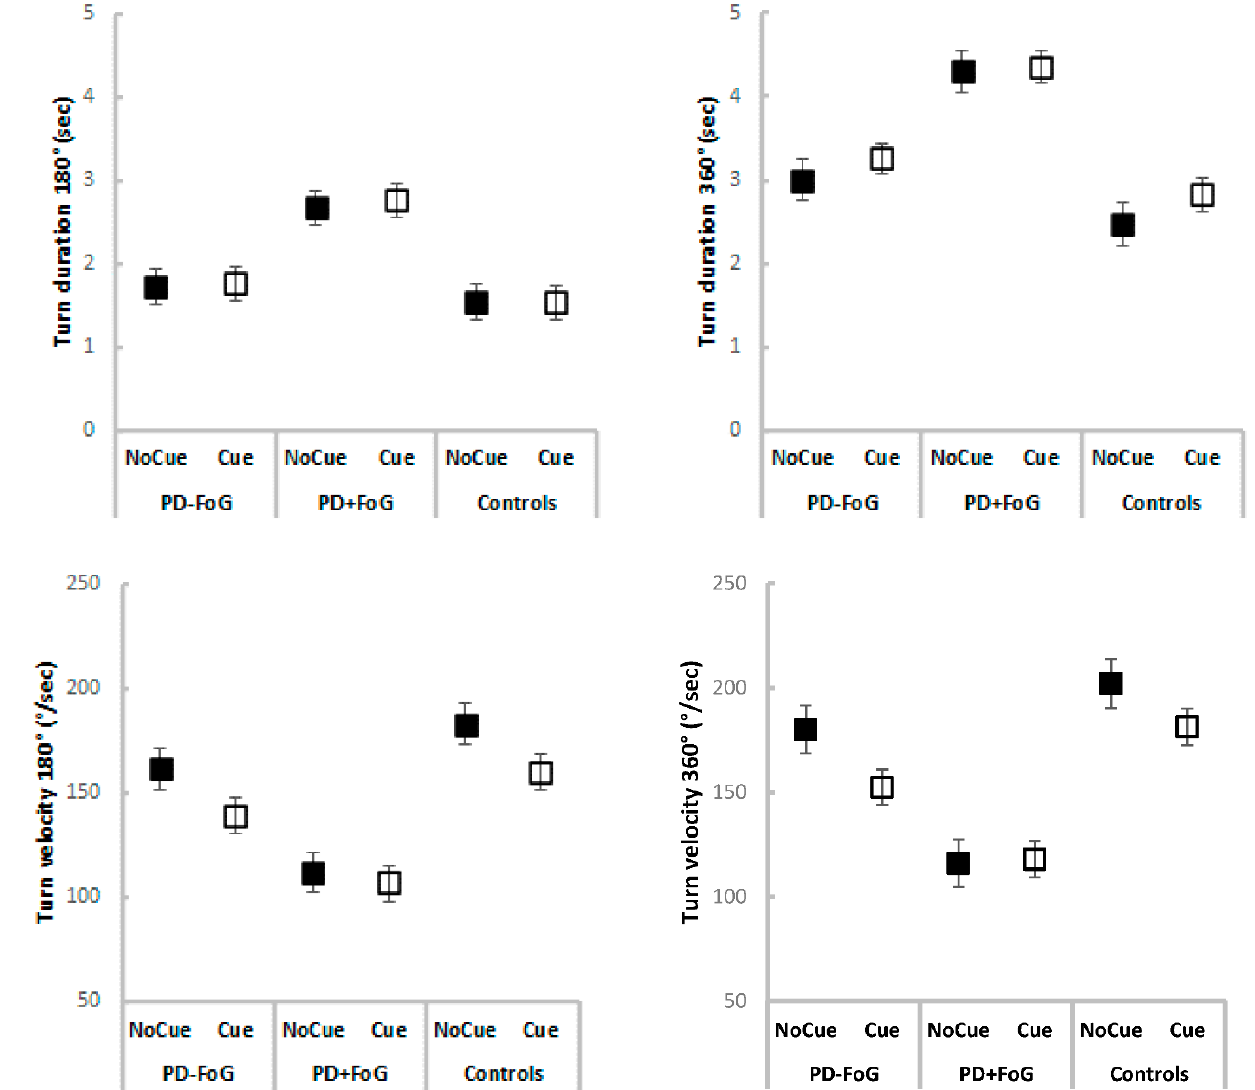
Figure 2. Turn outcomes (means and standard errors) for each group and cue condition. Table 3. Turn outcomes for PD groups (PD-FoG vs. PD+FoG) and condition, with results from the liner mixed effects models while controlling for disease severity (UPDRS-III).